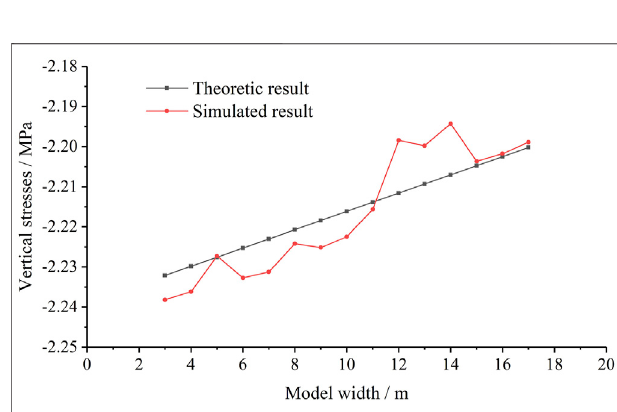
FIGURE 6 | Numerical model diagram of stope.